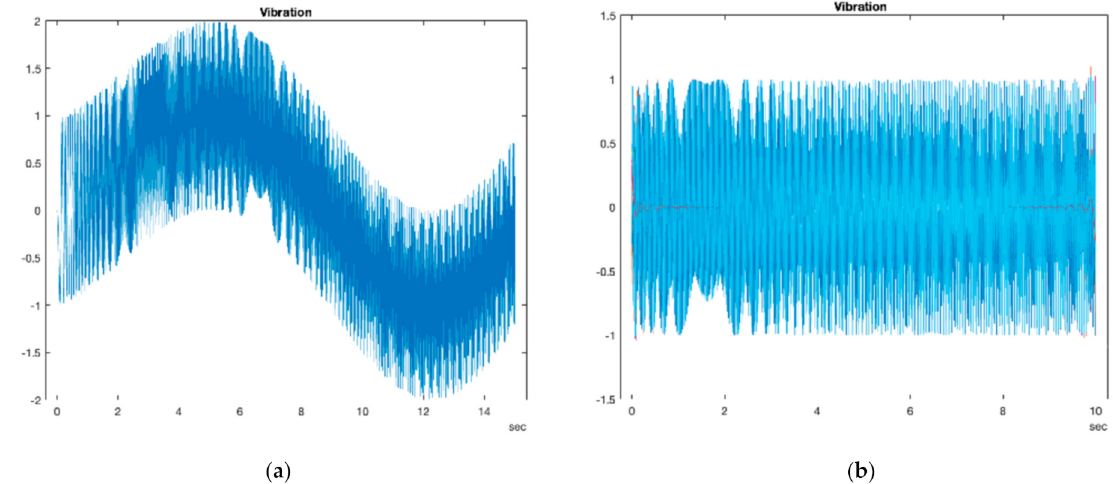
Figure 7. Effect of the preprocessing step proposed above, on an example vibration signal: ( a ) Vibration data before the proposed preprocessing step; ( b ) Vibration data after the proposed preprocessing